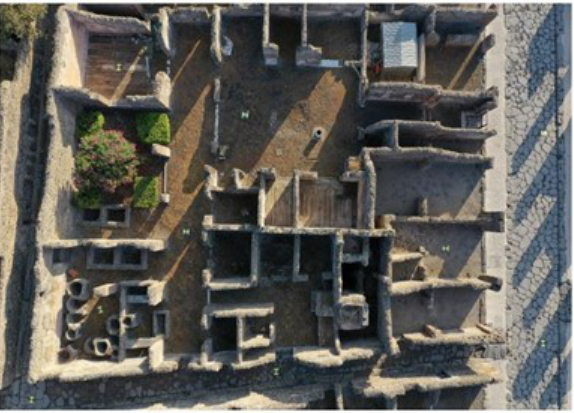
Figure 2. Aerial image of Domus